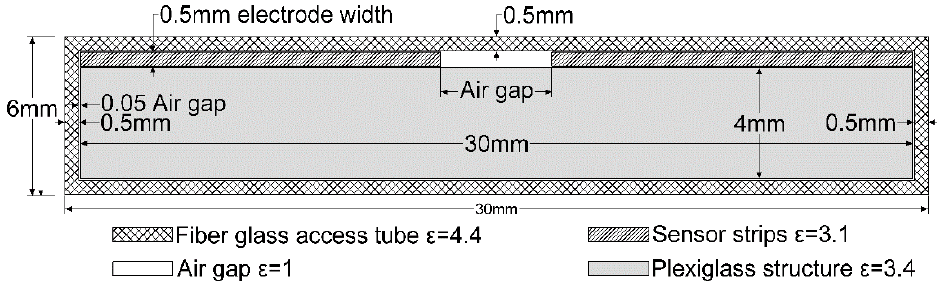
Figure 4. Typical top view of sensor model with two strip electrodes attached to a solid plexiglass structure enclosed by an access tube. The electrodes are separated in horizontal distance by a simulated air gap.